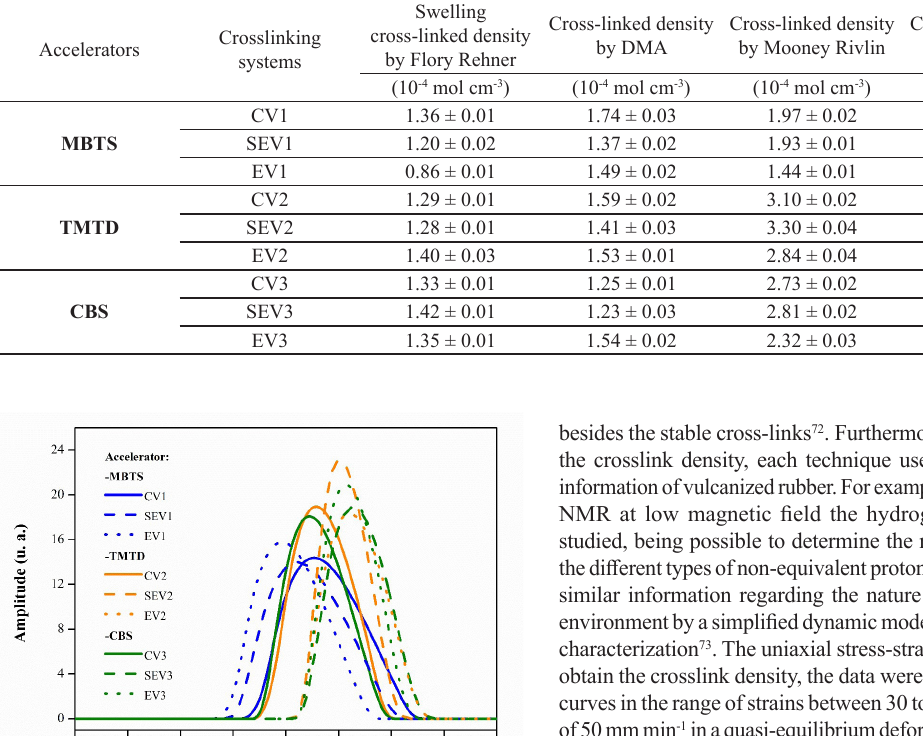
Table 4. Cross-linked densities of vulcanized NR compounds determined by the Swelling, DMA, Stress x Strain and 1 H NMR techniques in respective crosslinking systems.